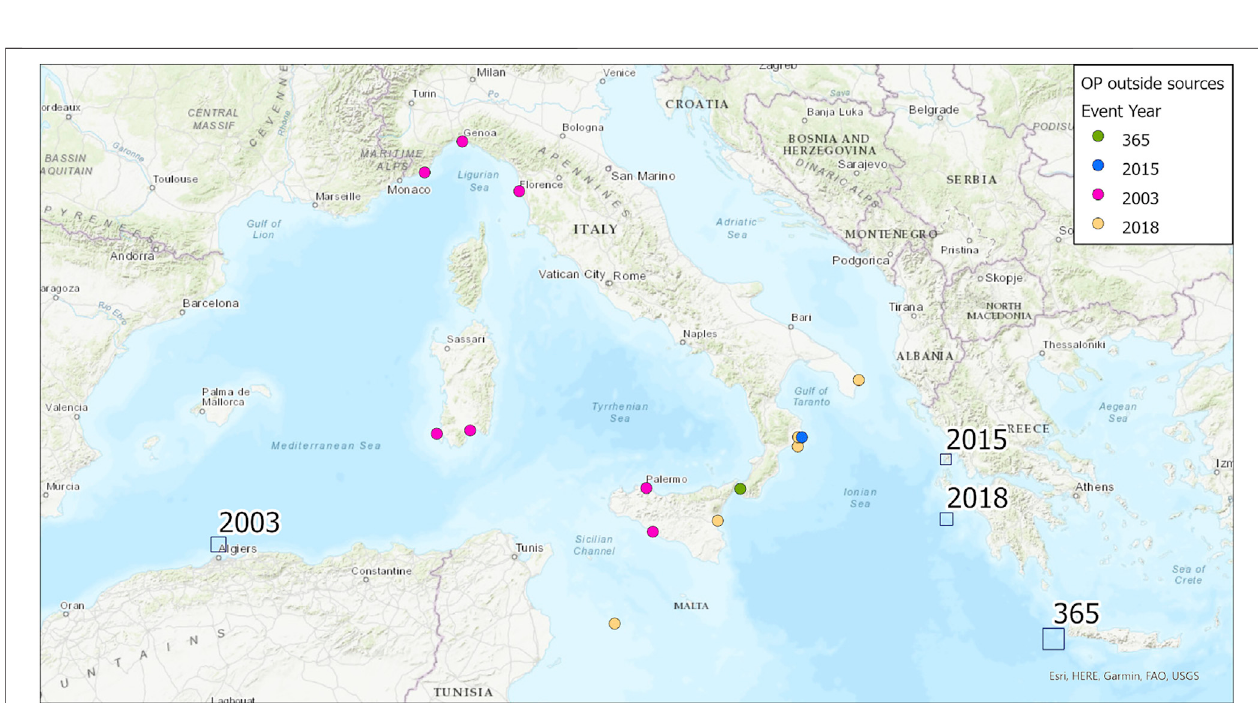
FIGURE 9 | Observation Points (OPs) related to the four tsunamis generated in the neighboring countries. Blue squares indicate the generating sources.